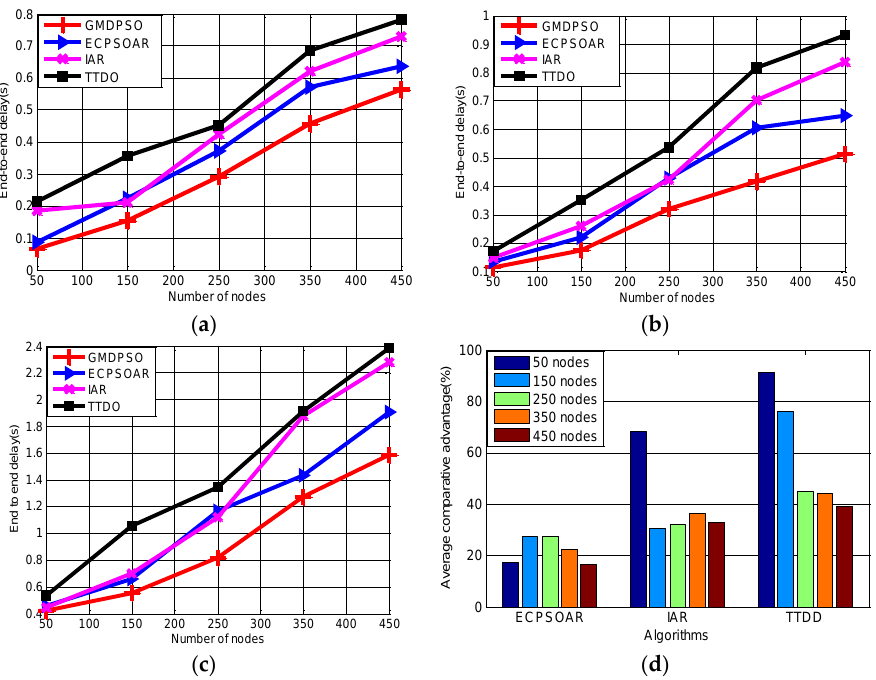
Figure 8. Average end-to-end delay with respect to different node failure probabilities. ( a ) When the node failure probability is 0.01; ( b ) When the node failure probability is 0.02; ( c ) When the node failure probability is 0.04; ( d ) Average EED comparative advantage. Table 5. Average end-to-end delay (EED) with respect to different P fault